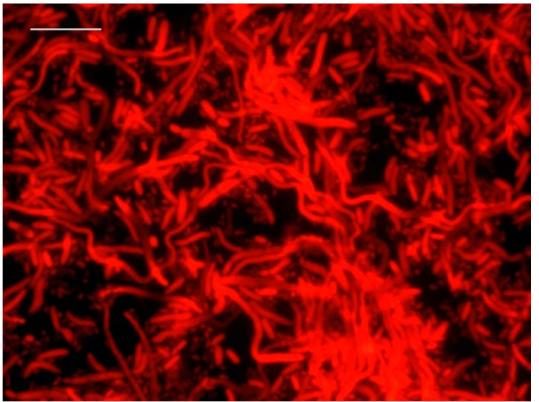
Figure 2. Viable but degraded V. parahaemolyticus cells after incubation in DVC broth (0.75 µ g/mL—7 h) (bar: 10 µ m).